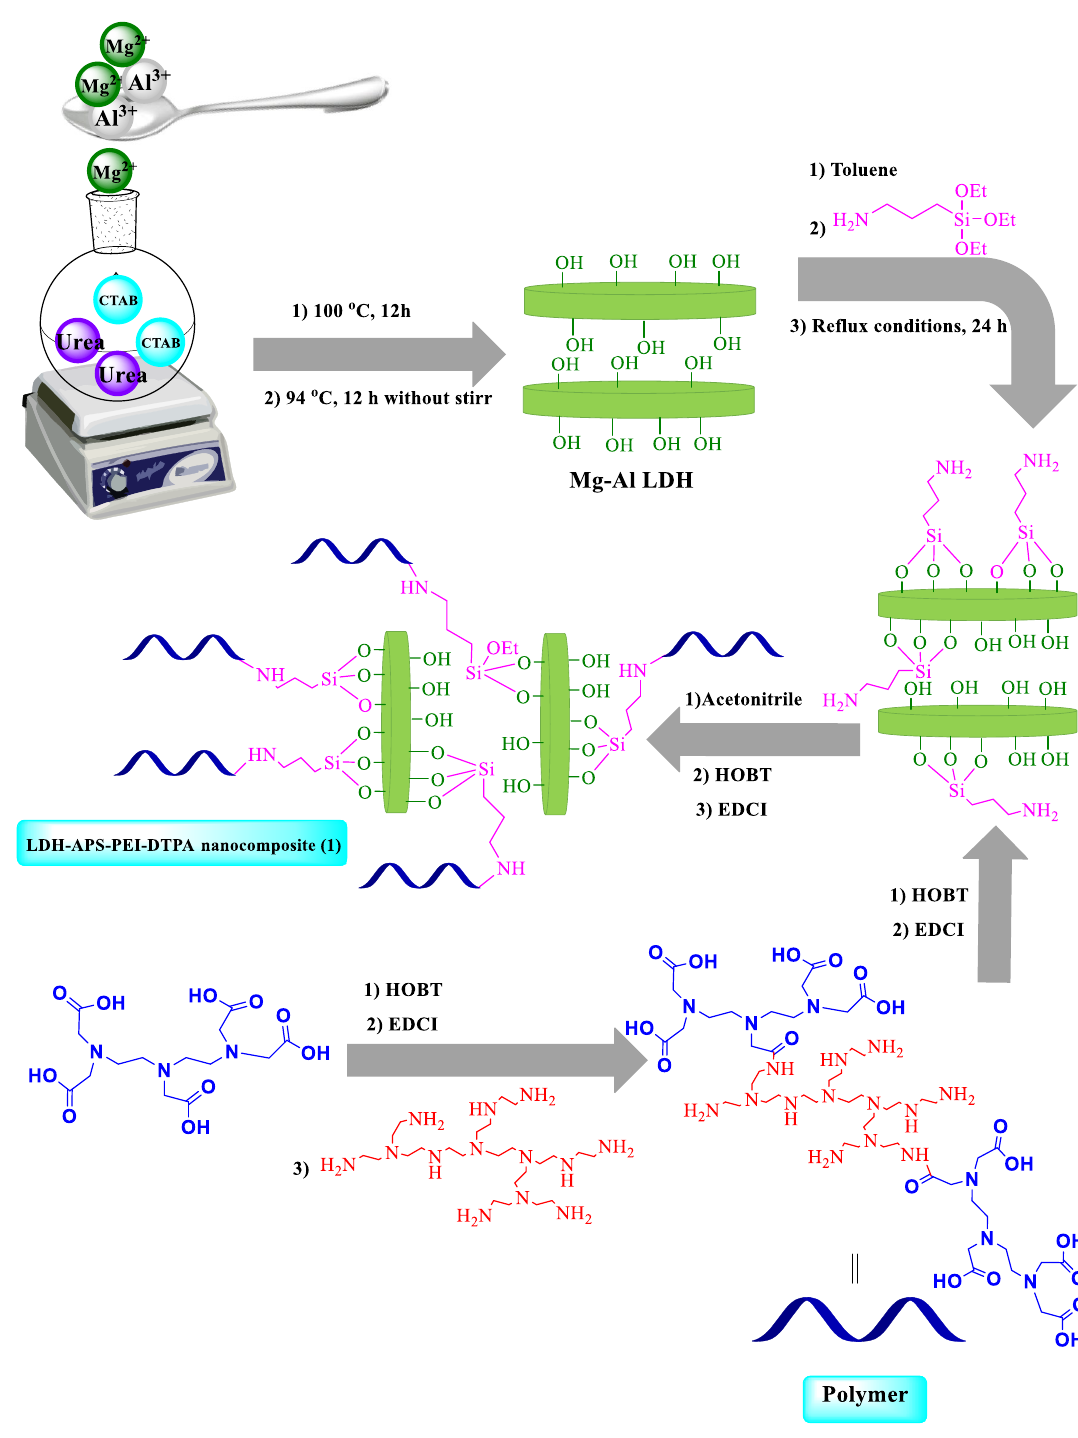
Figure 10 . Schematic preparation of LDH–APS–PEI–DTPA nanocomposite ( 1